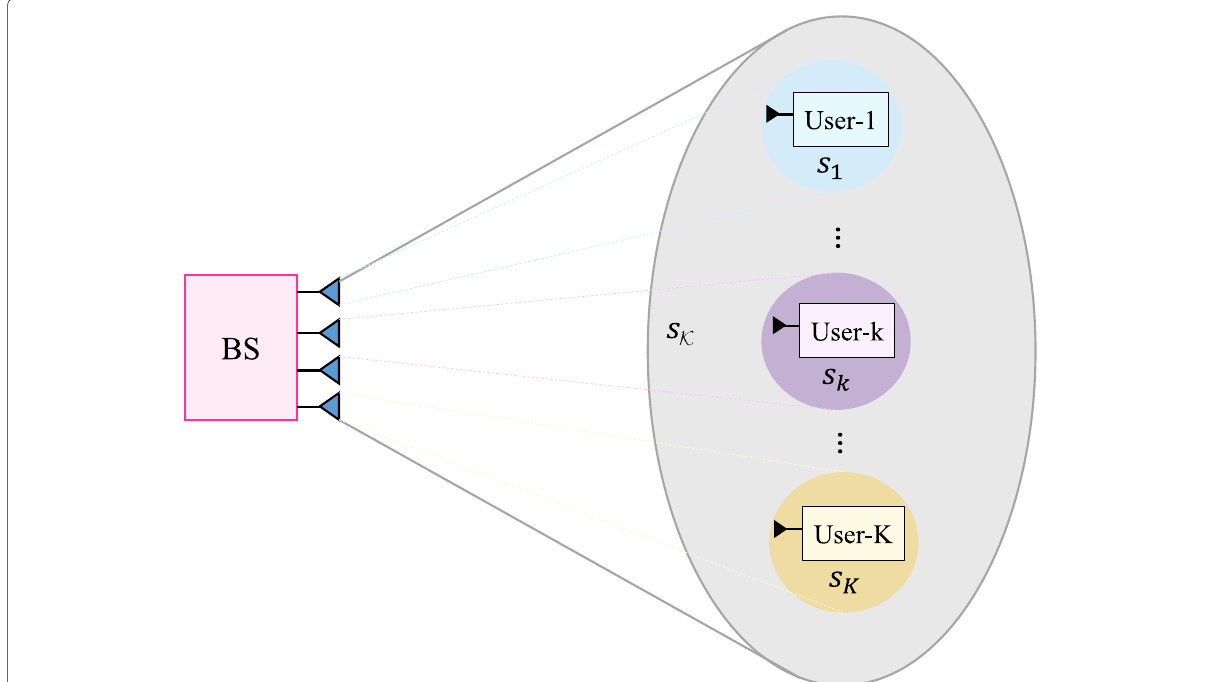
Fig. 3 One-layer RS model of K users. The common stream s K is shared by all the